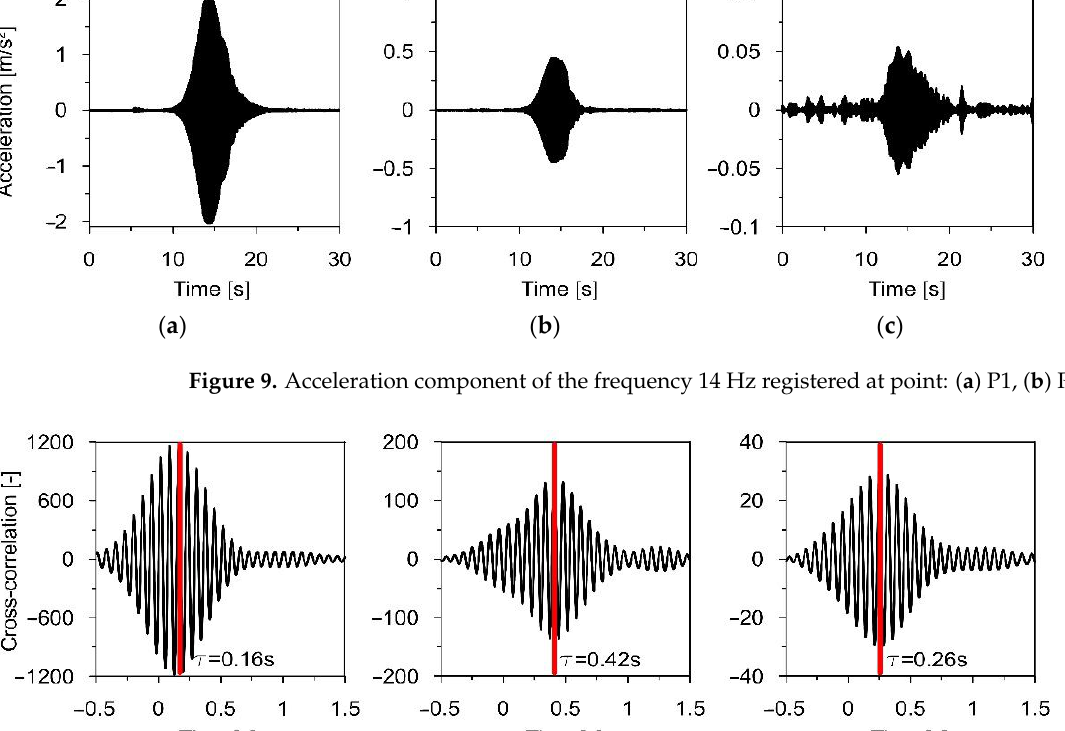
Table 3. Characteristics of excitation series executed during the in situ test.